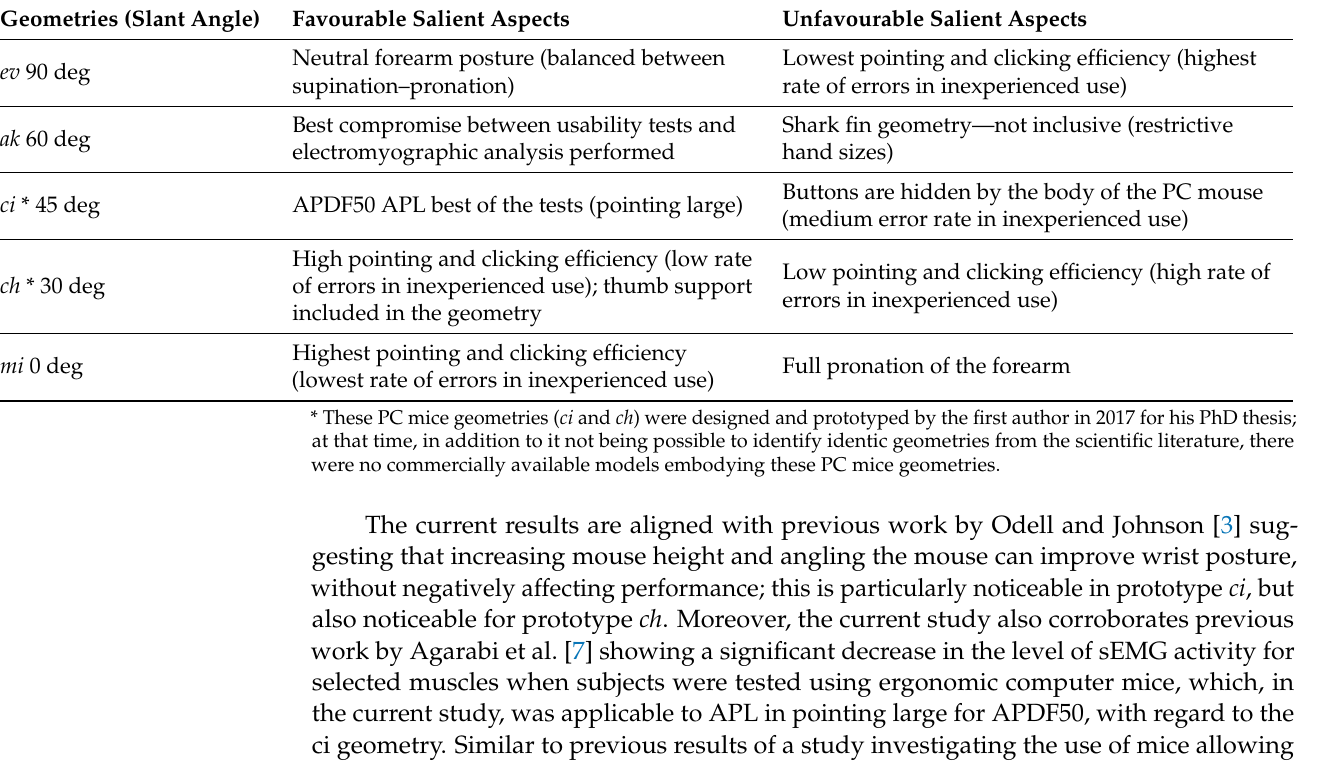
Table 4. Summary of relevant dichotomous highlights of the tested PC mice